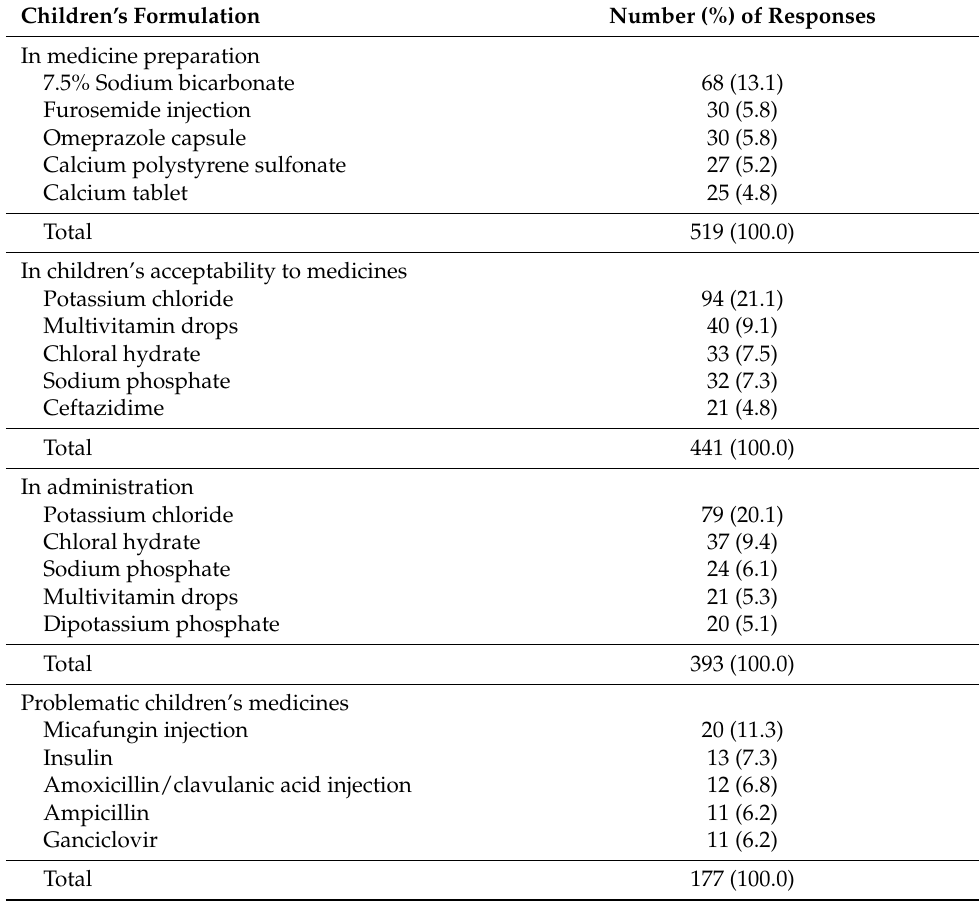
Table 6. Most needed children’s formulations unavailable in the hospital, as mentioned by